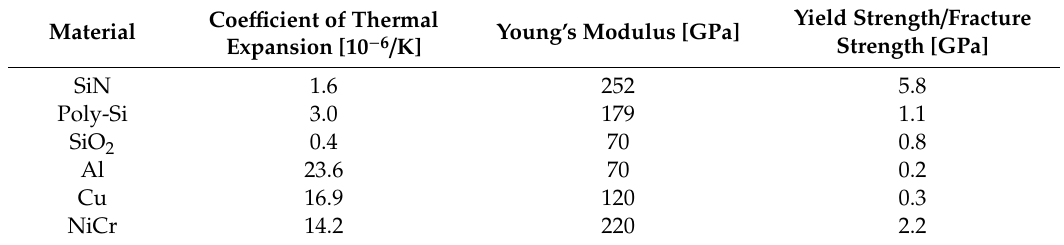
Table 1. Material selection of the electrothermal kirigami scanner [40–45].